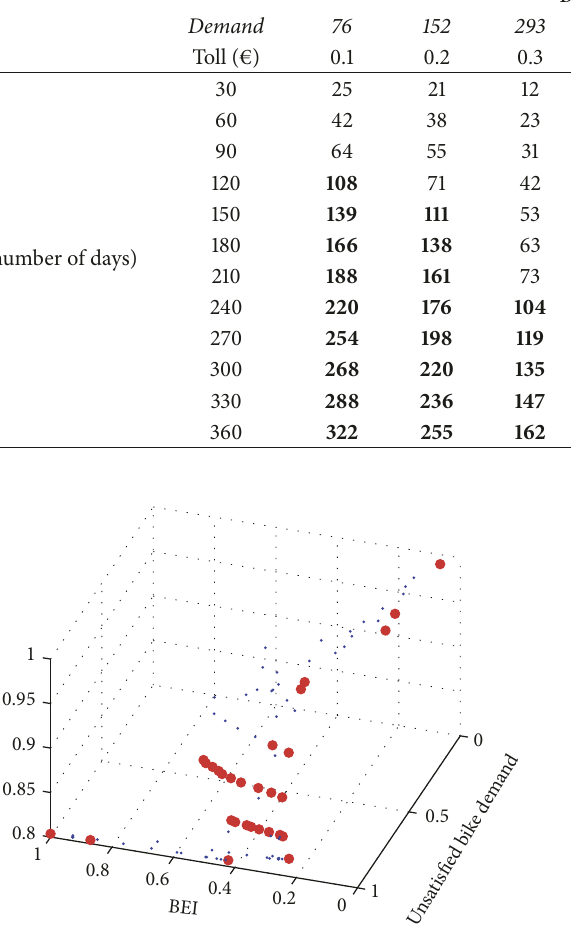
Figure 8: Graphical representation of the Pareto